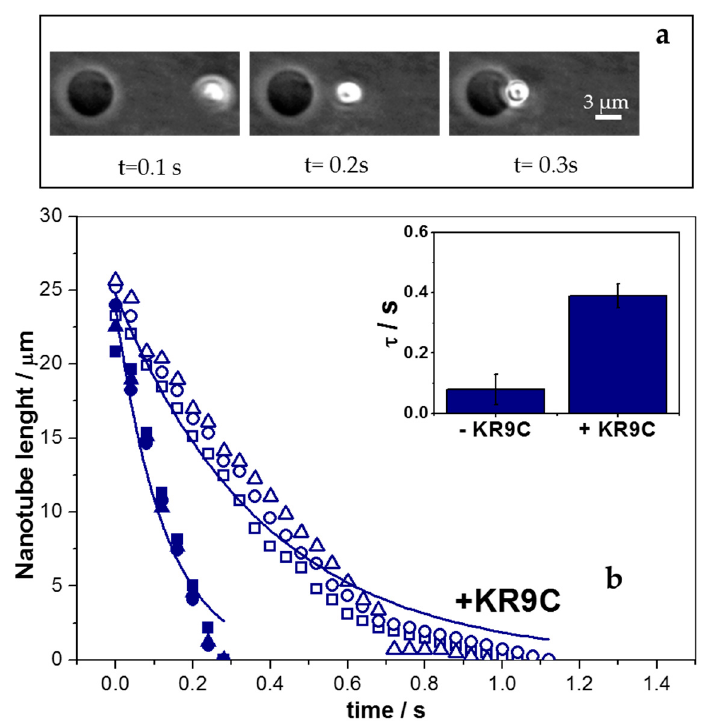
Figure 7. Nano-tube retraction experiments for GUVs composed of DOPC / DOPG. ( a ) Representative images at the indicated experimental times after switching off the trap in the absence of peptide. ( b ) Quantification of 3 nano-tube lengths as a function of time obtained from images, such as that in figure ( a ) in the presence (open symbols) and in the absence (closed symbols) of 2.5 µ M peptide. Each symbol type corresponds to a nano-tube retraction. The two lines correspond to the fitting of the data with circles of each set of experiments. Inset: Average values for τ ( ± SE), obtained from two GUVs of two independent experiments.